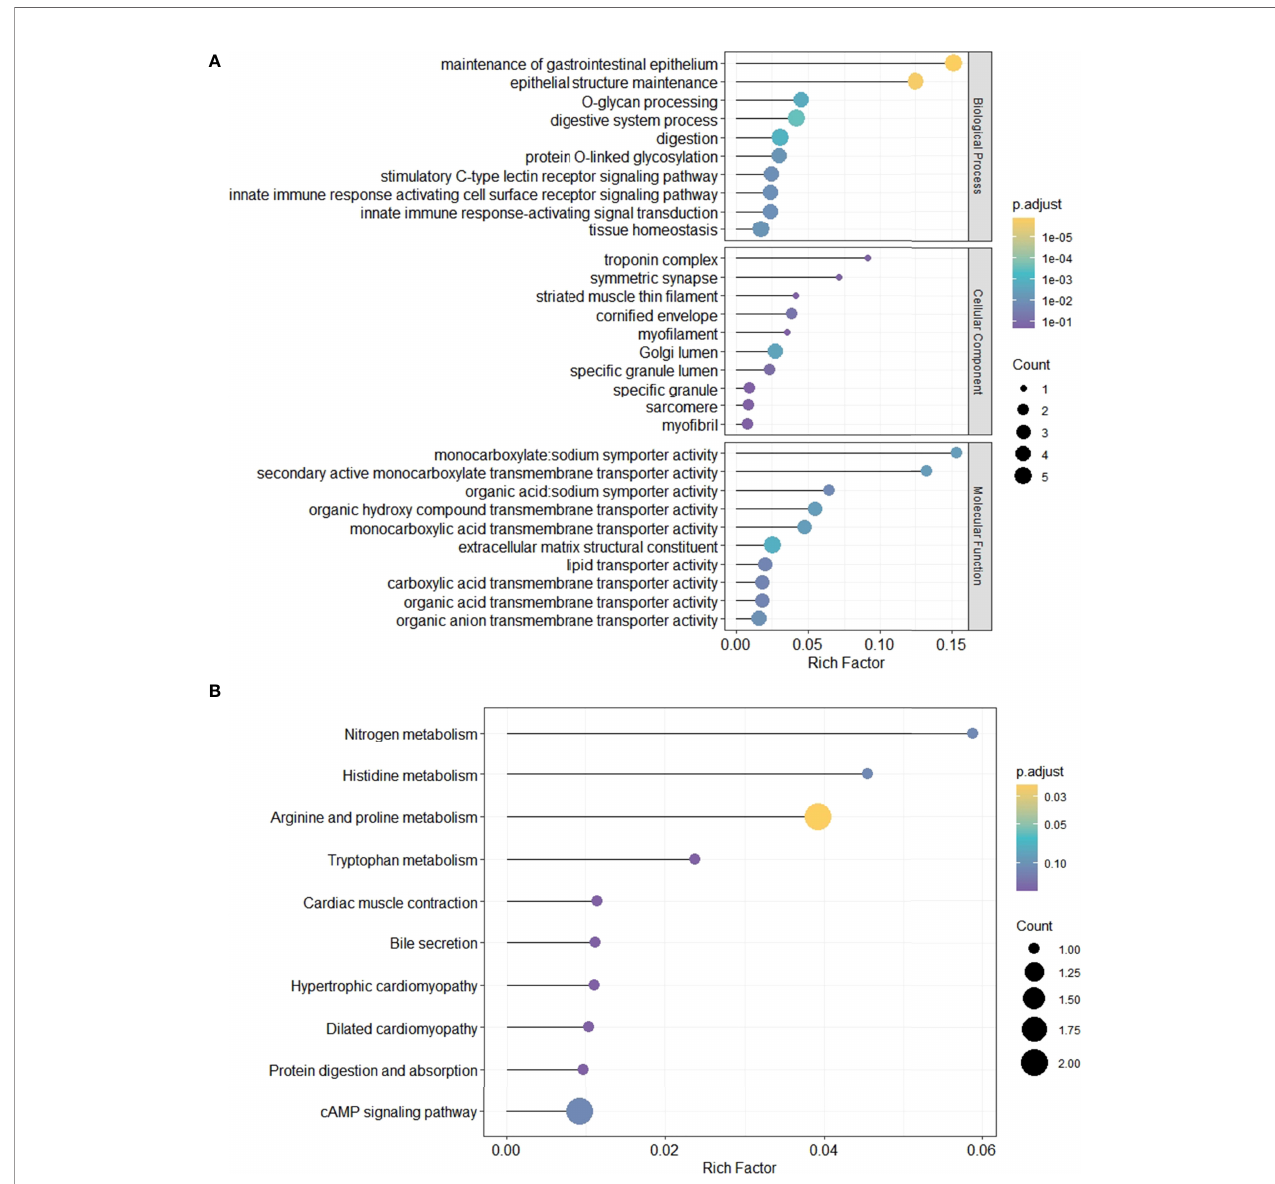
FIGURE 4 | GO and KEGG pathway enrichment analyses of DEGs between high- and low-risk LUAD patients. p -value: purple, high (bottom); yellow, low (top). The size of the dots represents the number of DEGs. (A) GO analysis results. (B) KEGG pathway enrichment analyses results. p .adjust, adjusted p